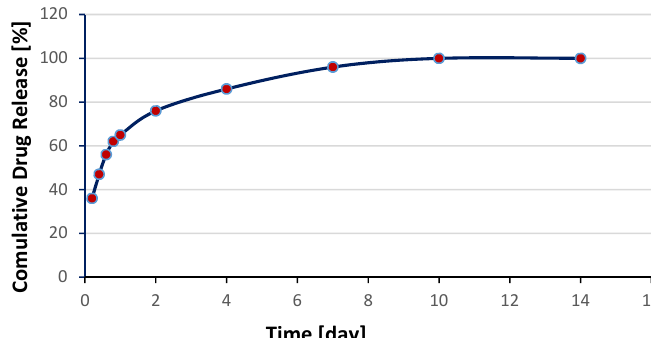
Fig .6 Curve of hemolysis rate of thin film